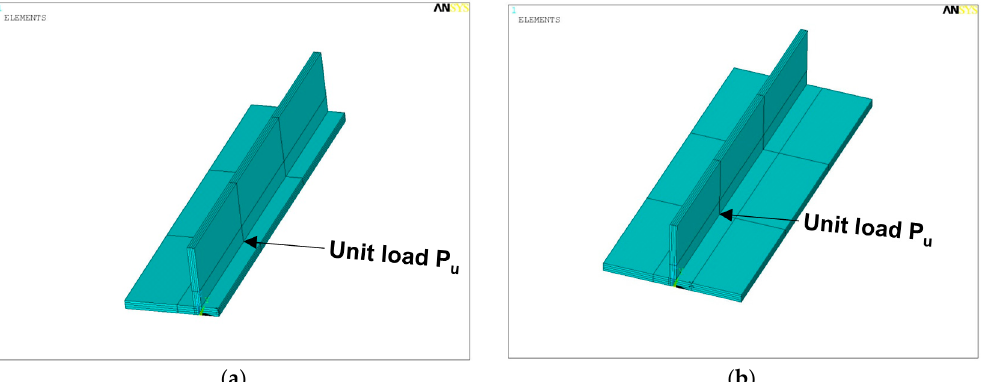
Figure 7. Degree of restraint of unit welding member: ( a ) without surrounding part, ( b ) with surrounding part.